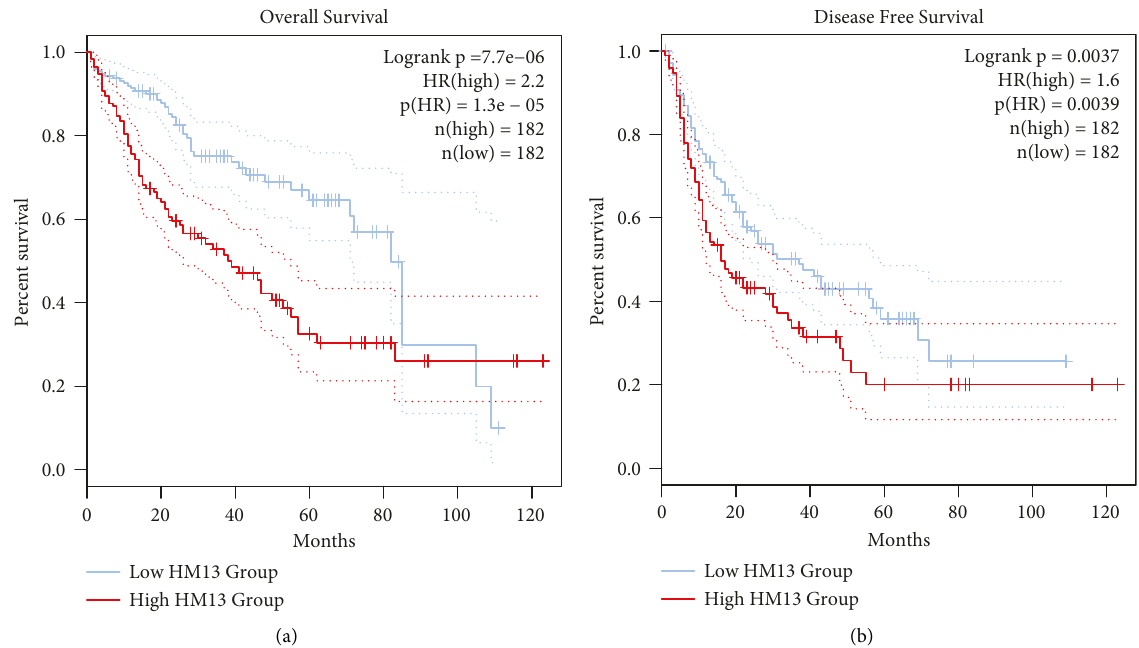
Figure 2: Higher expression of HM13 exhibited an association with worse OS and DFS. The survival curve showed that the (a) OS and (b) DFS of patients with highly expressed HM13 were lower compared to that of patients with lowly expressed HM13 in the GEPIA